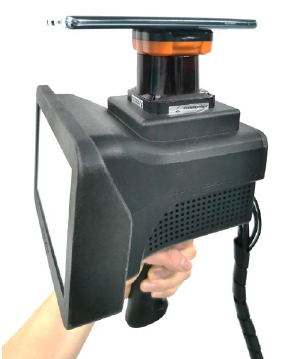
Figure 3. A handheld SLAM positioning